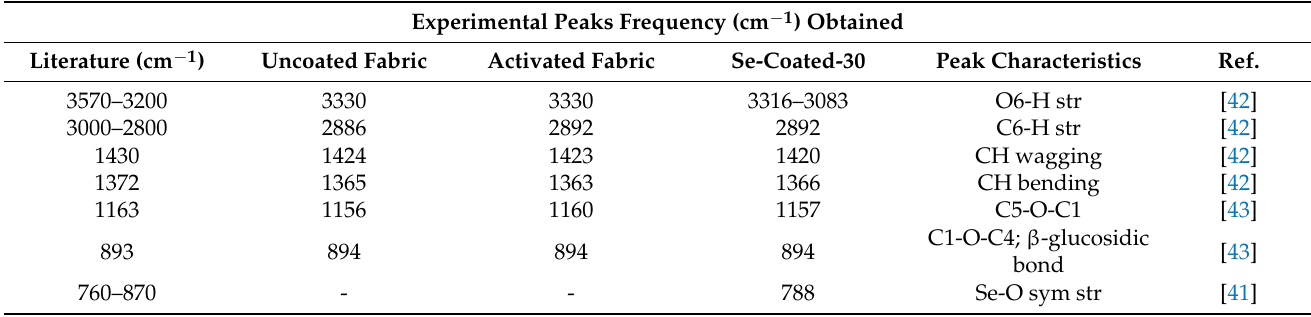
Table 2. Showing frequencies (cm − 1 ) of Uncoated, Activated and Se-coated-30 fabric samples in FTIR.